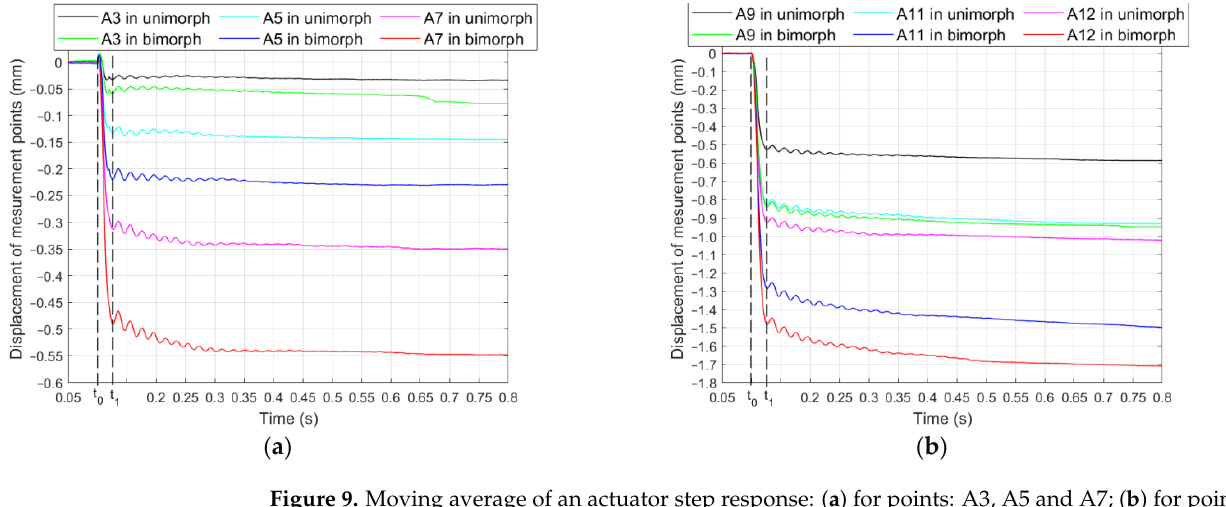
Figure 9. Moving average of an actuator step response: ( a ) for points: A3, A5 and A7; ( b ) for points: A9, A11 and A12.